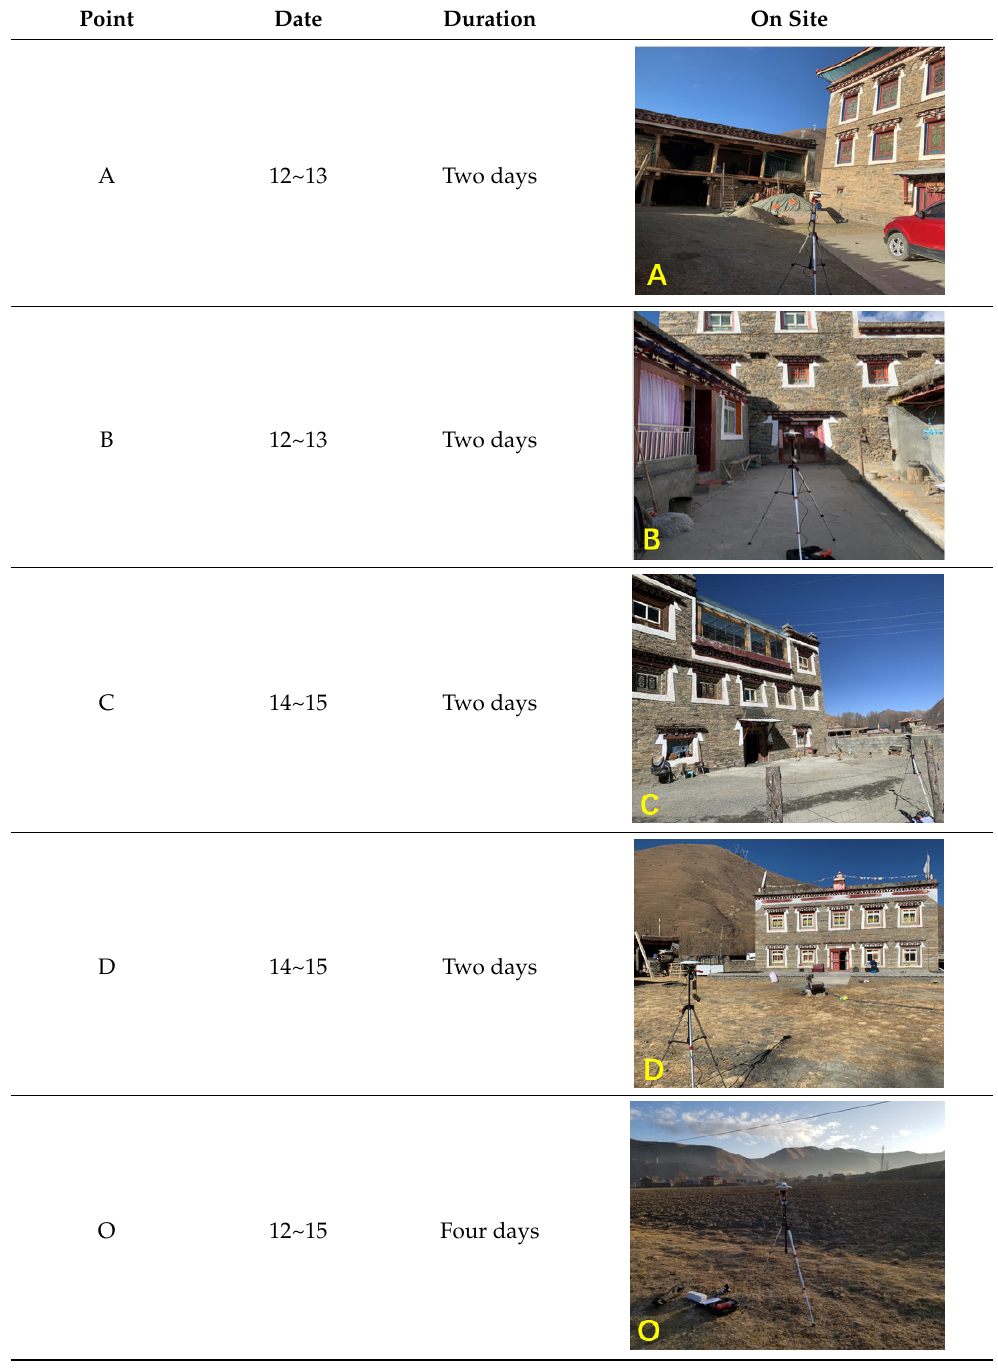
Table 2. Measurement date, time, and on-site photos.